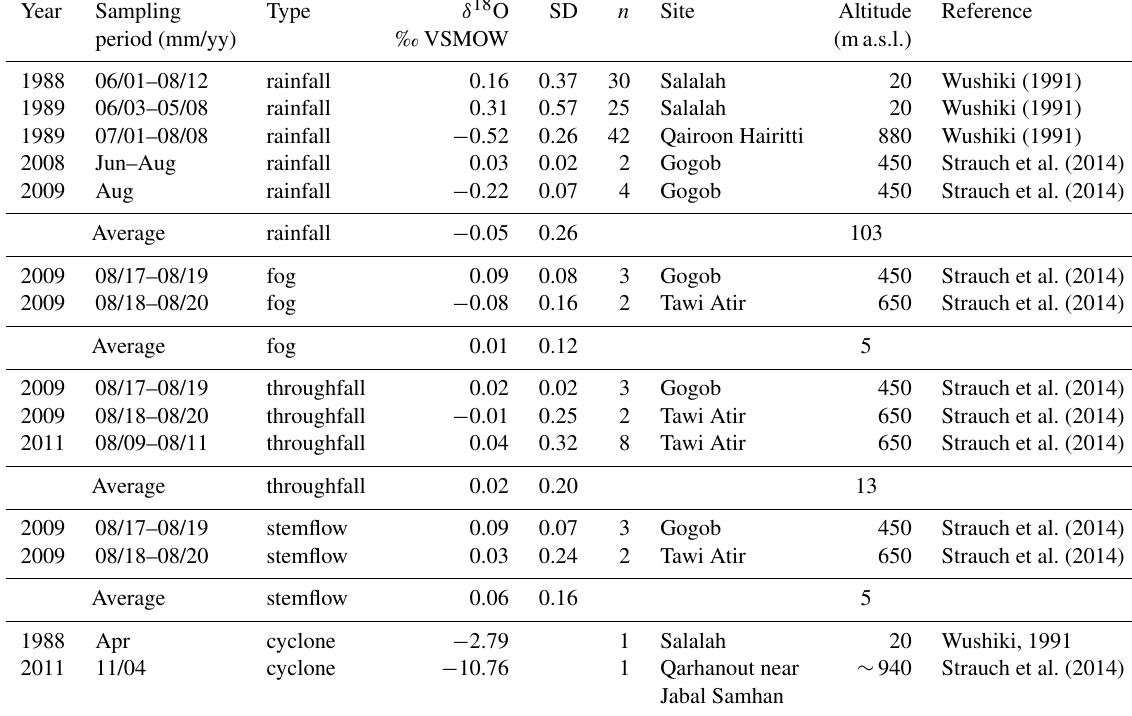
Table 1. Compilation of published oxygen stable isotope data of monsoon rainfall, fog, stemflow, throughfall and cyclone water from the Dhofar Mountains for different years. Site coordinates are as follows: Salalah (17 ◦ 01 (cid:48) N, 54 ◦ 04 (cid:48) E), Qairoon Hairitti (17 ◦ 15 (cid:48) N, 54 ◦ 05 (cid:48) E), Gogob (17 ◦ 12 (cid:48) N, 54 ◦ 06 (cid:48) E), Tawi Atir (17 ◦ 06 (cid:48) N, 54 ◦ 31 (cid:48) E), and Qarhanout (17 ◦ 07 (cid:48) N, 54 ◦ 37 (cid:48)